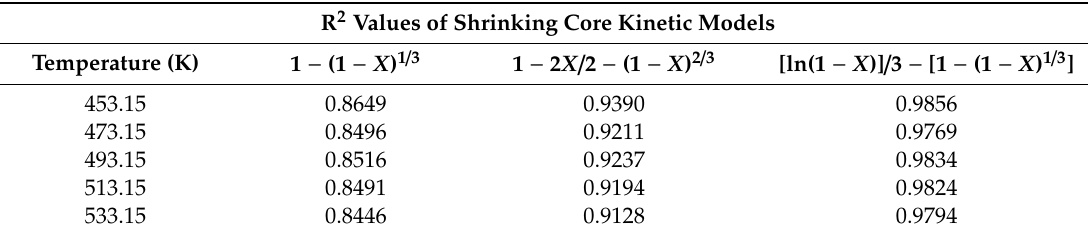
Table 1. R 2 values of shrinking core kinetic models for 2.5 h of leaching at di ff erent temperatures. R 2 Values of Shrinking Core Kinetic Models